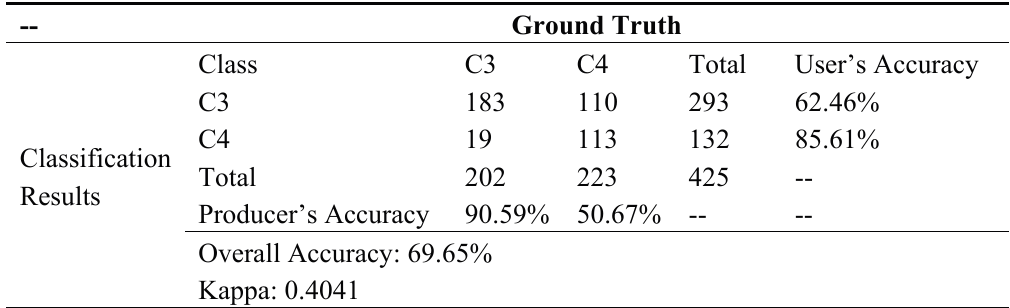
Table 6. C3 and C4 classification accuracy of moderate resolution imaging spectroradiometer (MODIS) time-series data.